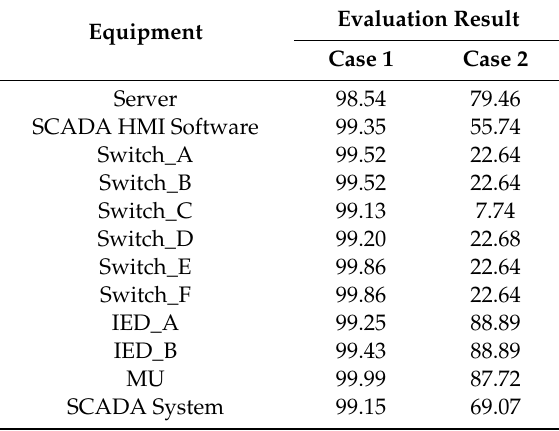
Table 24. The equipment FCE result of case 1 and 2.